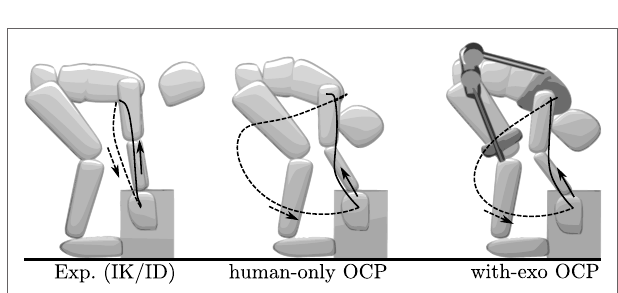
FIgURe 6 | The experimental subject guides their hands directly to the box, while the OCP solutions swing the arms (dashed lines). During the lifting phase, experimental subject and the OCP solutions follow similar paths. The difference in the hip, knee, and lumbar-flexion angle can be seen between the experimental subject and the two OCP solutions when the box is being picked up.